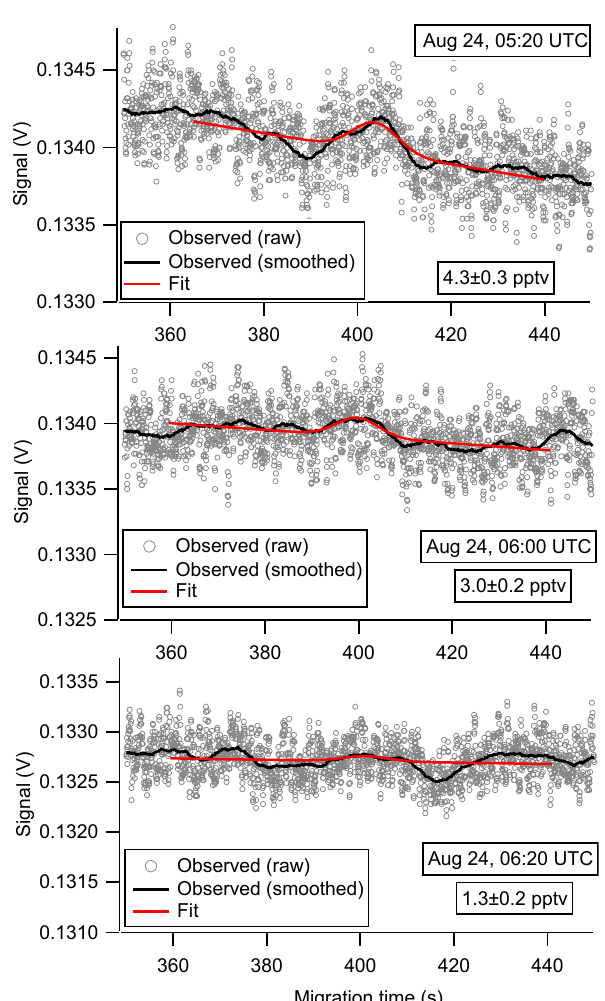
Figure A5. Sample chromatograms of MPAN acquired on 24 August 2013 (analogous to those in Fig. A4 in the Appendix and Fig. 15) used to estimate the limit of detection for